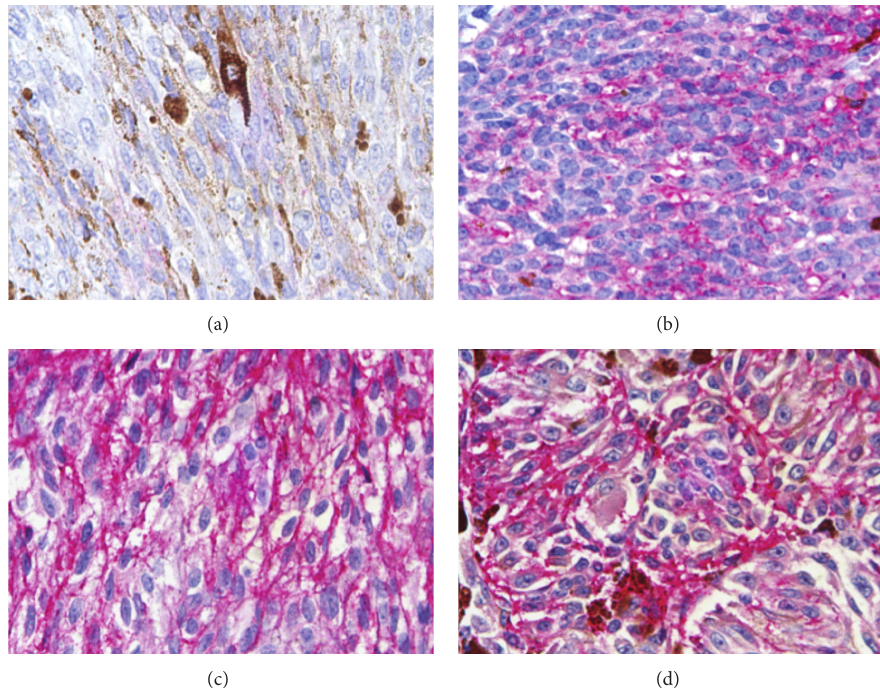
Figure 1: KAI1 in uveal melanoma. (a) Mild and focal cytoplasmic positivity in spindle cell malignant melanoma (640x). (b) Mild and diffuse cytoplasmic positivity in epithelioid malignant melanoma (640x). (c) Strong and diffuse cytoplasmic positivity in mixed (spindle-epithelioid) malignant melanoma (640x). (d) Strong and diffuse cytoplasmic positivity in epithelioid malignant melanoma (640x).